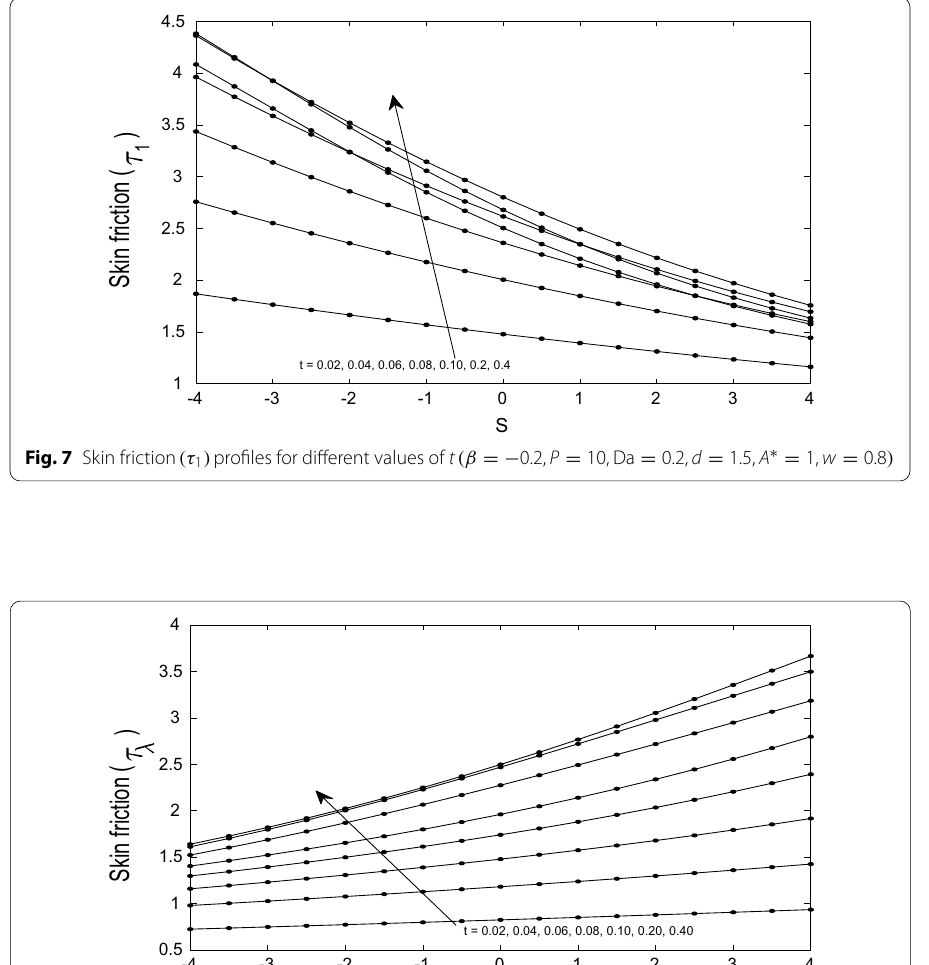
0.2, P 10,Da 0.2, d 1.5, A ∗ 1, w 0.8 ) = − = = = = =